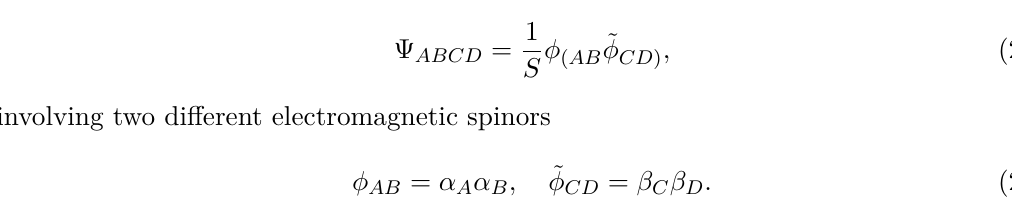
which is clearly of Petrov type D. This is not the only way to obtain such a Weyl